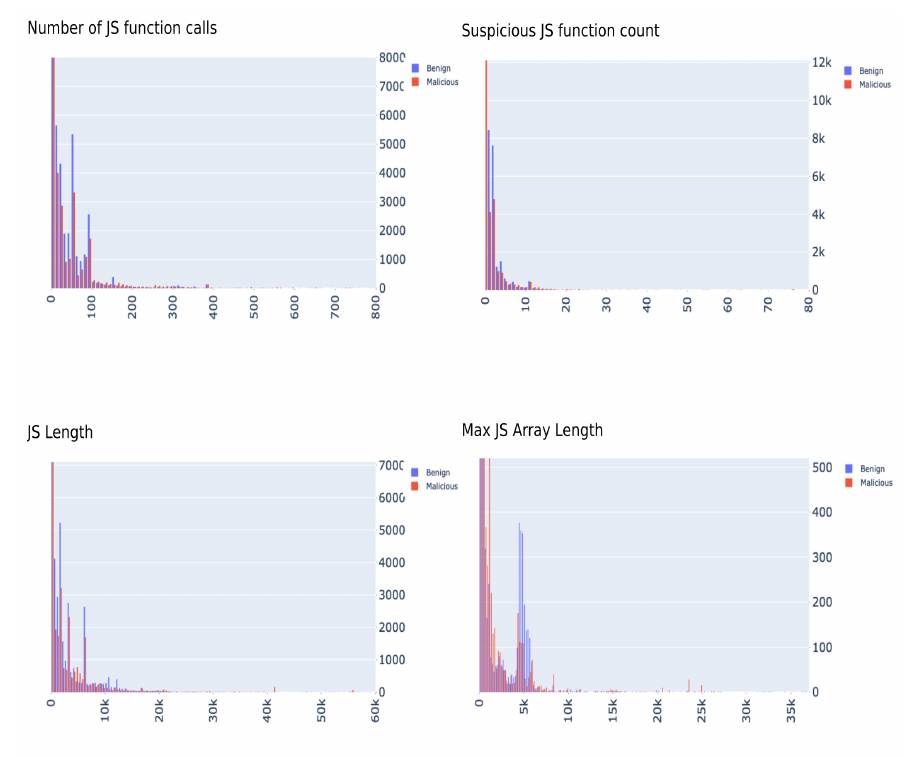
Figure 3. GAWAIN’s JavaScript distribution